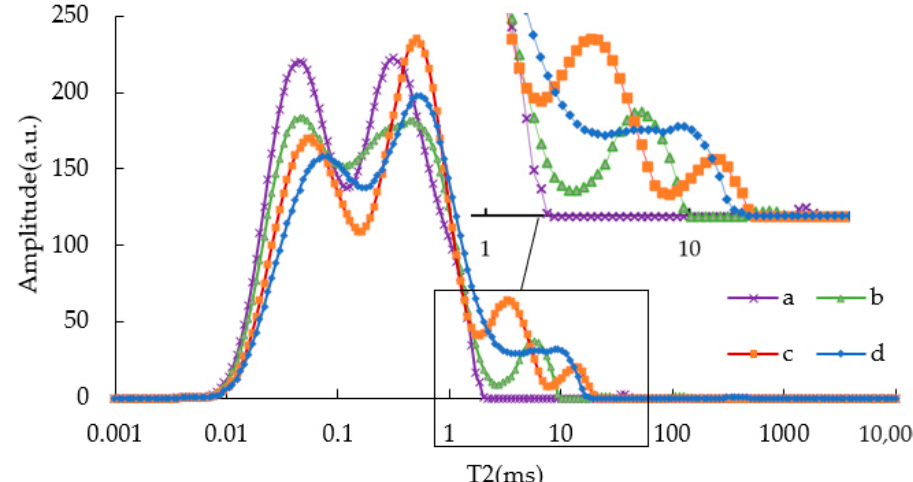
Figure 2. T2 of SBS asphalt binders unaged.